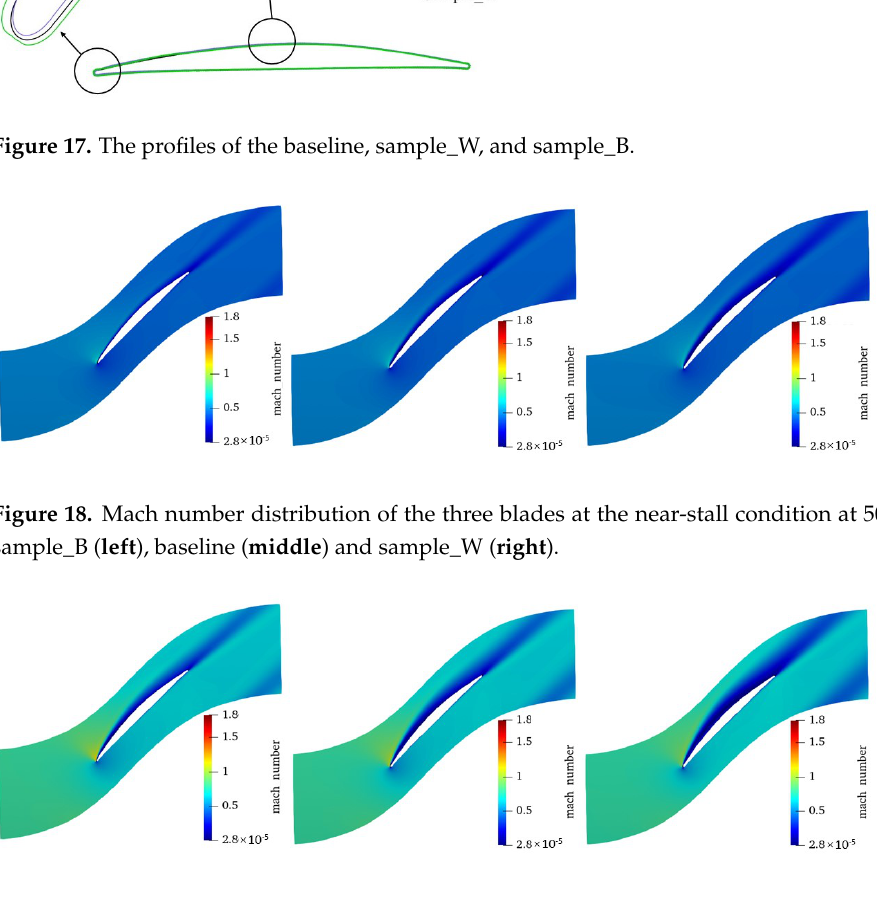
Figure 19. Mach number distribution of the three blades at the near-stall condition at 80% speed: sample_B ( left ), baseline ( middle ) and sample_W ( right